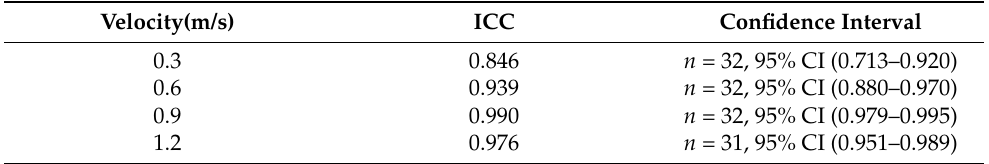
Table 1. Intraclass correlation coefficients between medial gastrocnemius peaks detected by mTrigger and DELSYS for treadmill walking at various walking